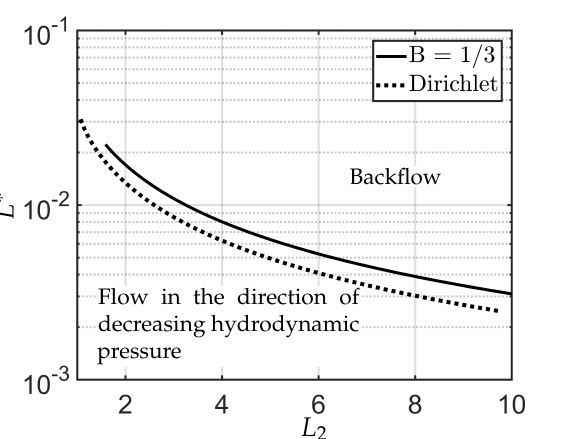
Figure 5. Phase space plot of the parameters ( L ∗ and L 2 ) for no overall mass flow rate. Here ˜ p x > 0. The curve (solid) corresponding to B = 1/3 is for the asymmetric boundary condition (Equation (16)). The dotted curve is for the case of the symmetric (Dirichlet) boundary condition (Equation (15)). The values of the parameters used are ˜ p x = 1, ω = 1/2 and L 1 = 10 − 6 .